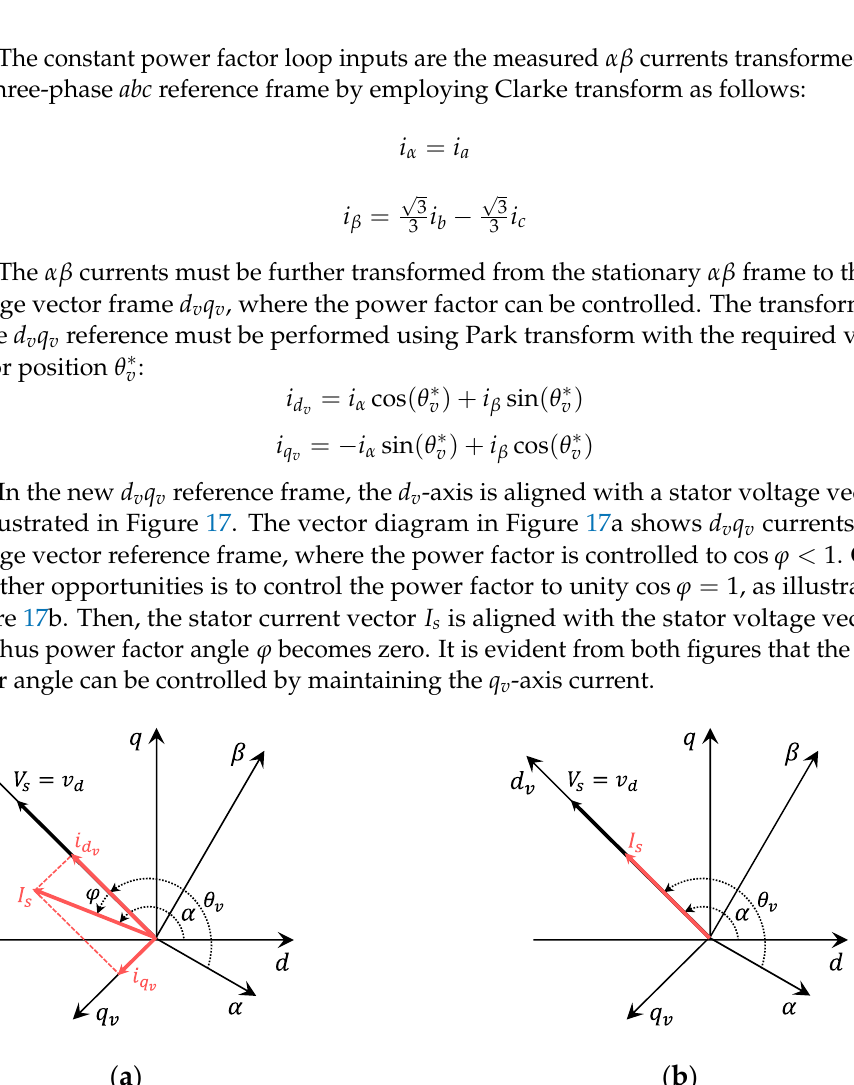
Figure 16. Block diagram of the constant power factor loop.